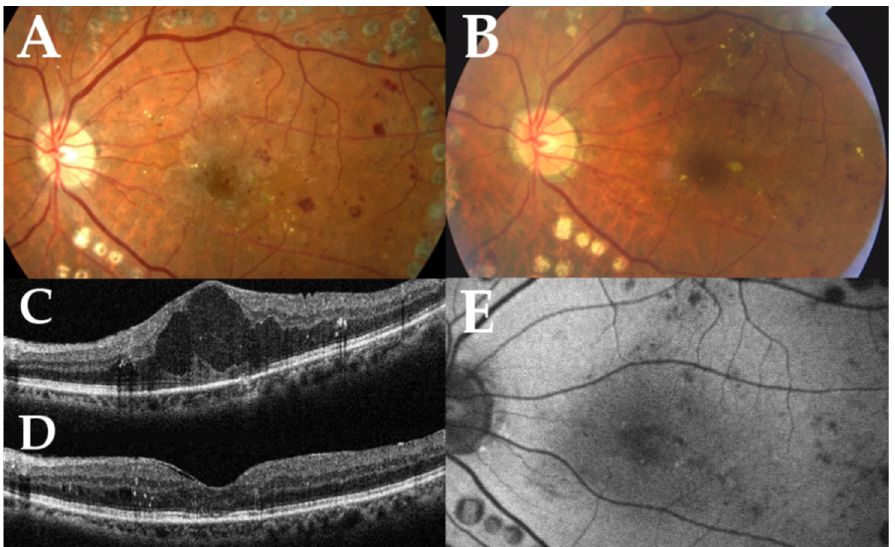
Figure 1. A representative case of a 57-year-old male with diabetic macular edema (DME) treated by red subthreshold micropulse laser (SMPL). ( A ) Color fundus photography of the left eye at baseline reveals center-involving DME. His left visual acuity was 0.7 on the decimal scale. ( B ) Color fundus photography of the left eye at 12 months from baseline reveals complete resolution of DME. No visible laser spot is detectable. His left vision improved to 1.0 on the decimal scale. ( C ) A spectral- domain optical coherence tomography (SD-OCT) image of the left macula at baseline demonstrates the cystoid macular edema (CME) with a disrupted ellipsoid zone. Central retinal thickness (CRT) was 673 µm. ( D ) An SD-OCT image of the left macula at 12 months from baseline demonstrates complete resolution of CME and improved integrity of the ellipsoid zone. CRT drastically decreased to 237 µm. ( E ) Fundus autofluorescence of the left macula at 12 months from baseline shows no visible laser spot. Dark spots around the fovea represent retinal hemorrhages shown in the color fundus photograph ( B ).